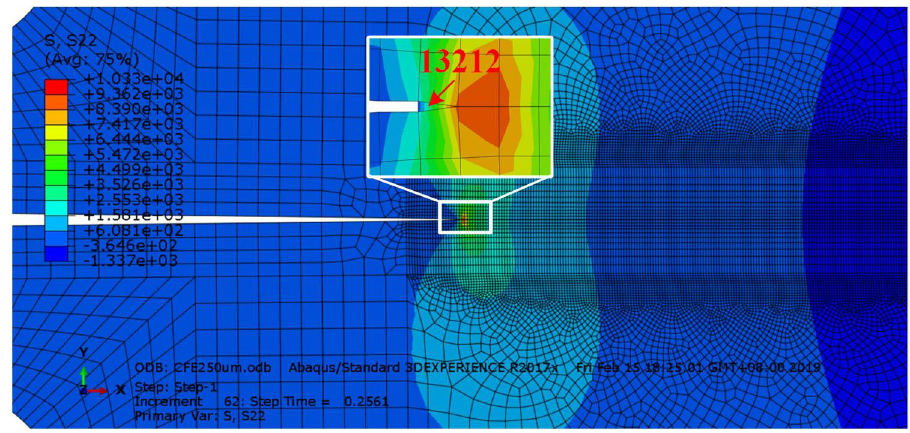
Figure 19. Schematic diagram of 13212 cohesive unit at crack tip.